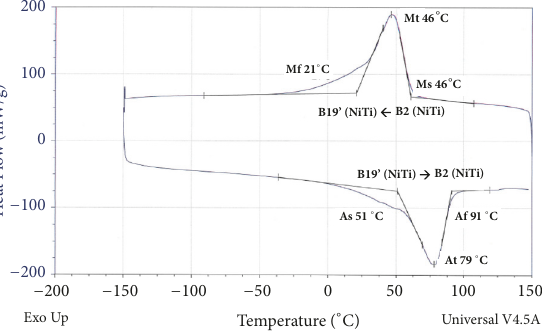
Figure 5: DSC of porous Nitinol indicating an equiatomic or titanium-rich matrix